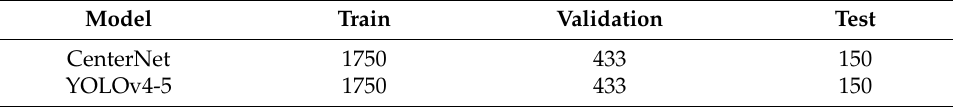
Table 1. Data splitting for training.